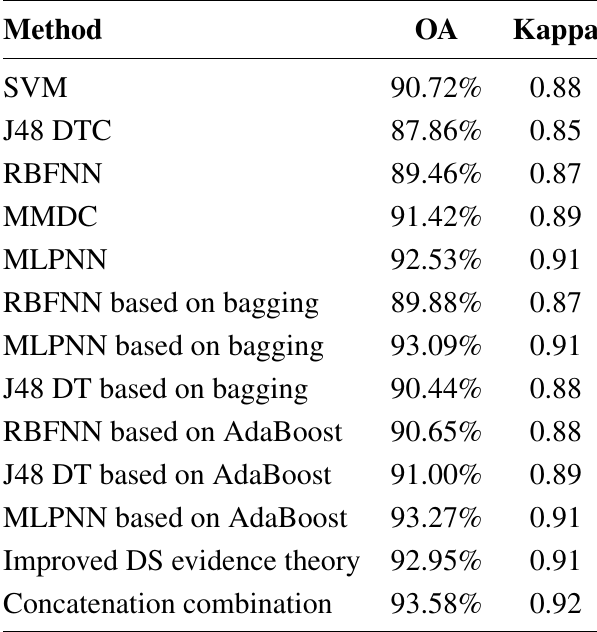
Table 10. Classification accuracy